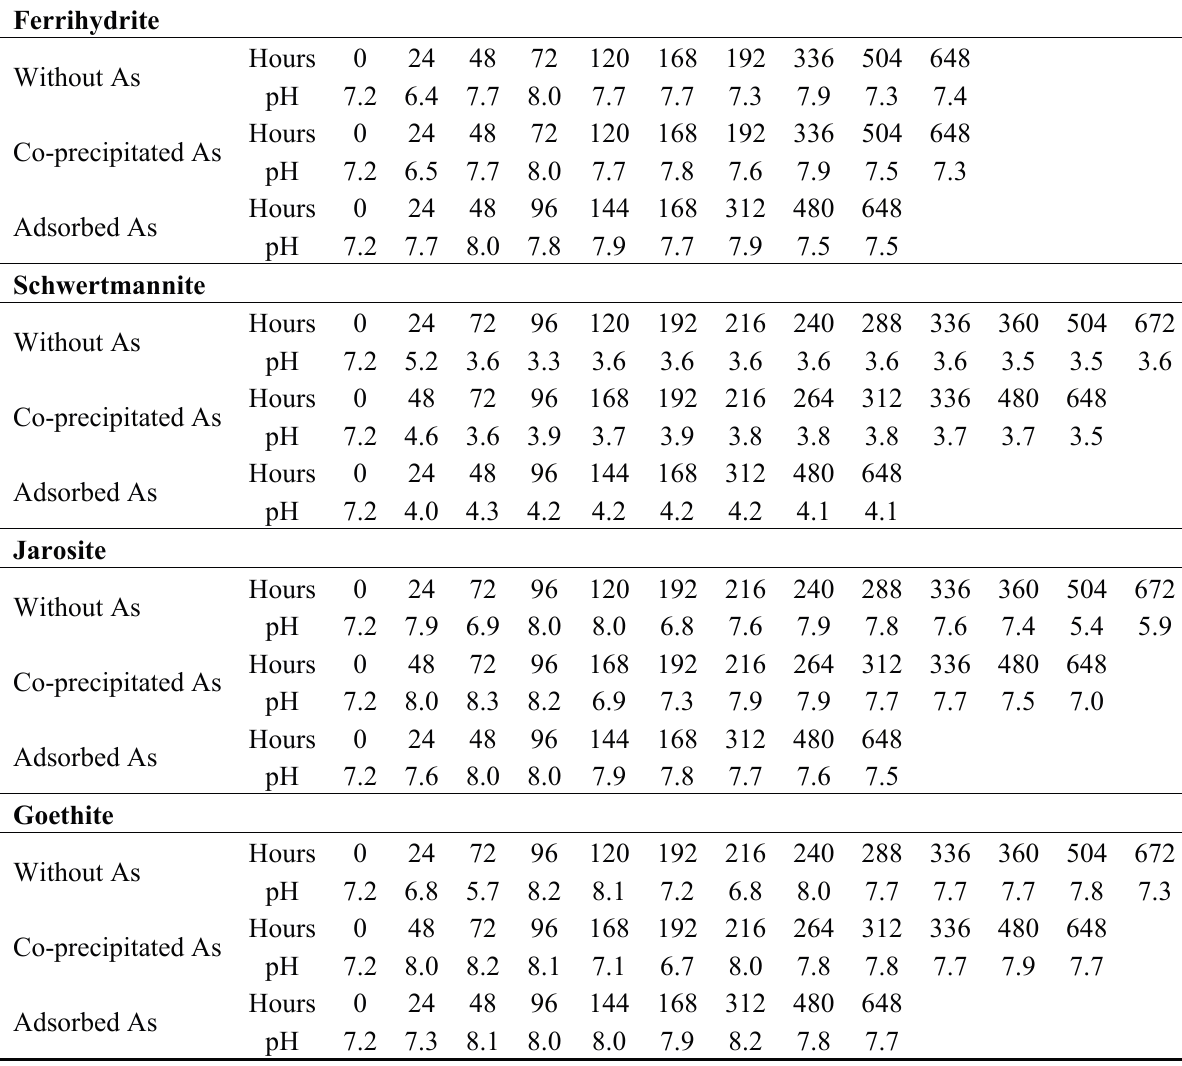
Table 7. pH during seawater